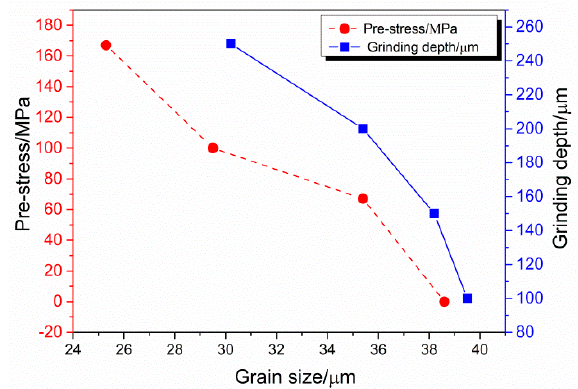
ff erent pre-stresses and grinding Figure 10. Grain sizes of different pre-stresses and grinding depths. Figure 10. Grain sizes of di